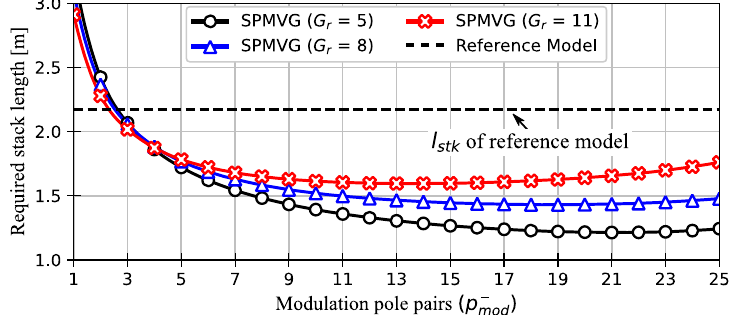
Figure 7. Required stack length l stk for 15 MW ( 𝐺 (cid:3045) = 5, 8,11 and 𝑝 (cid:3040)(cid:3042)(cid:3031)(cid:2879) = 1~25 ).